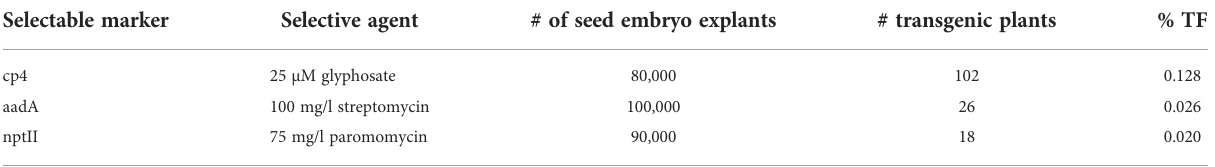
TABLE 2 Regeneration of transgenic plants from three different selectable markers cp4, aadA and nptI I. Selectable marker